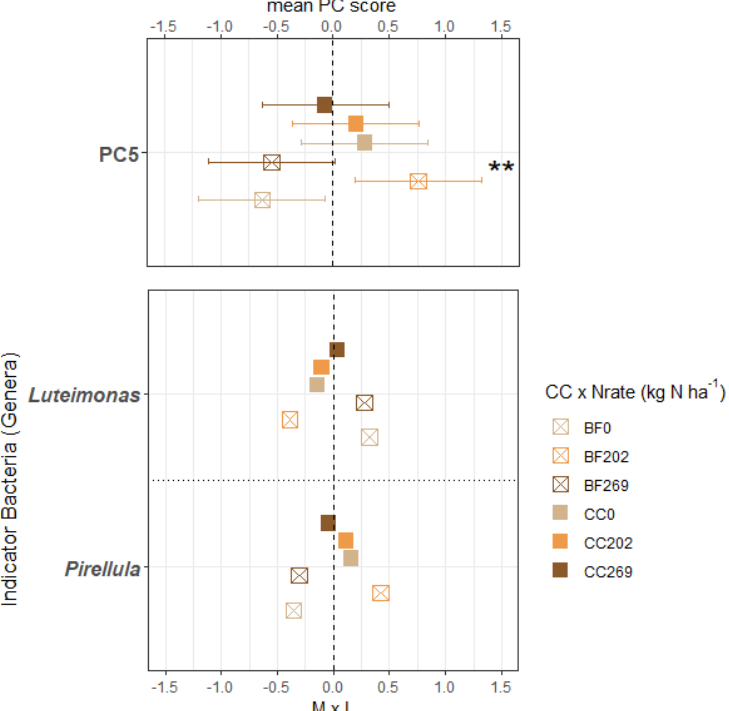
Figure 4. The top panel shows the estimated mean principal component (PC) scores of the bacterial PC5 for each level of N rate and cover cropping (CC × Nrate) treatment interaction with their standard errors of the mean as whiskers. The asterisks indicate the probability value of the treatment effect from analysis of variance (**: p < 0.05). The bottom panel shows the contribution of each bacterial indicator to PC5 multiplied by the mean PC scores of each level of N rate and cover cropping treatment interactions (M × L). The N rate treatment levels are: 0 kg N ha −1 (tan), 202 kg N ha −1 (orange), and 269 kg N ha −1 (brown). The cover cropping treatment levels are bare fallow (BF; crossed box) and cover crop mixture (CC; filled box).